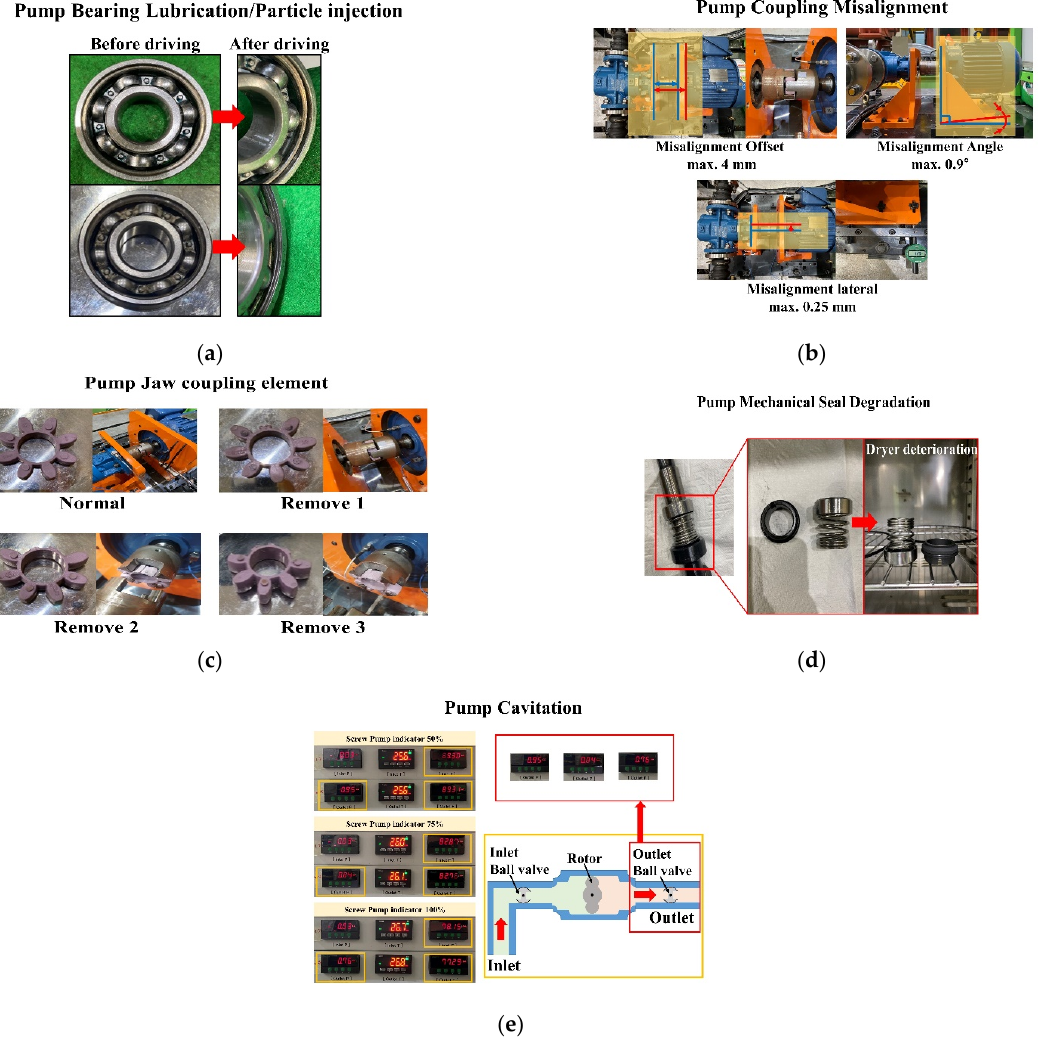
Figure 3. The picture for the process of performing of the fault simulation test for the fault modes of pump: ( a ) Motor and pump bearing lubrication and particle injection test; ( b ) Misalignment test; ( c ) Jaw coupling element test; ( d ) Mechanical seal degradation test; and ( e ) Cavitation